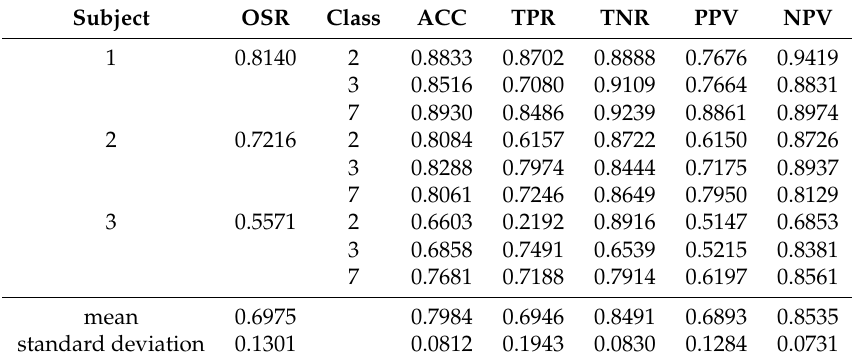
Table 7. ROC parameters for all three subjects and all three classes for each of